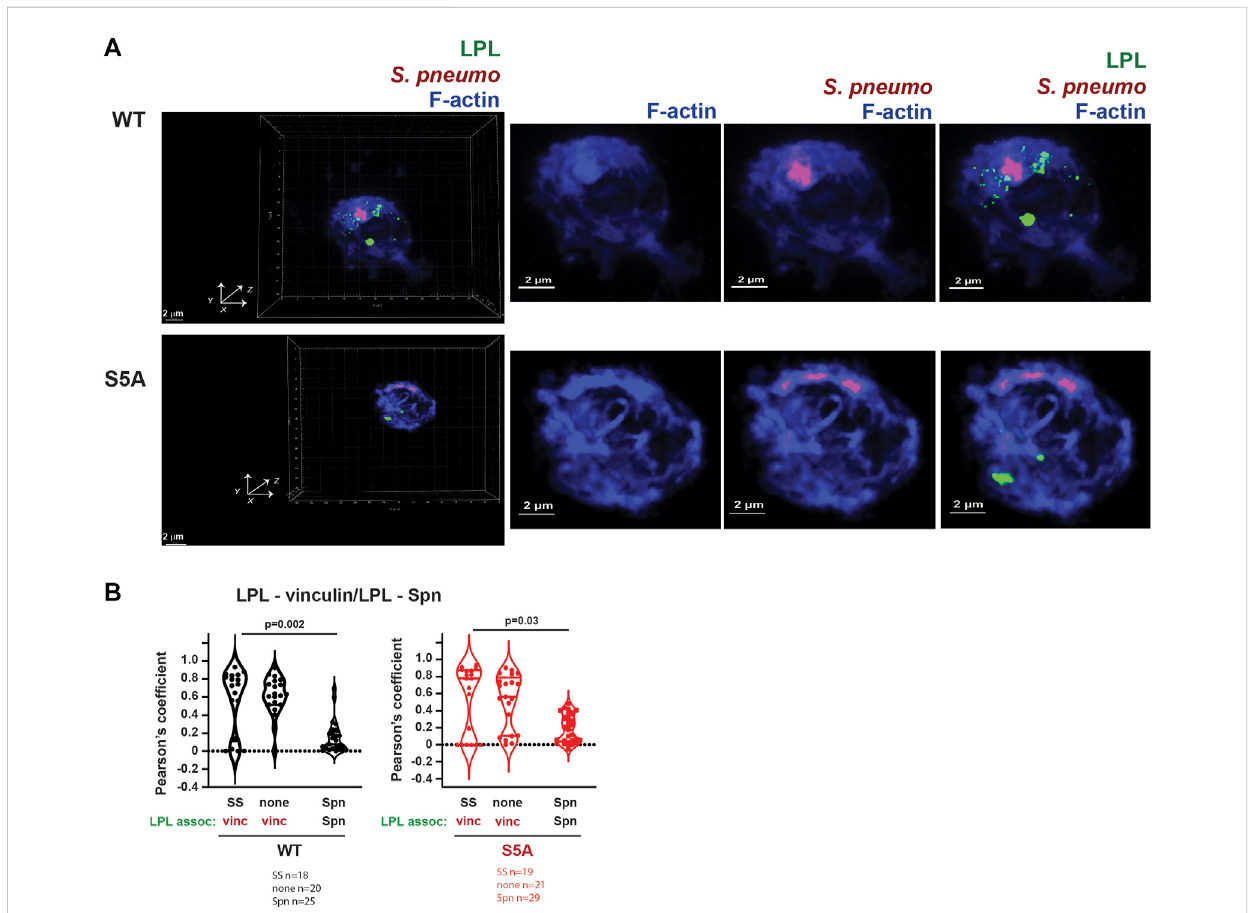
FIGURE 12 Neither WT-LPL nor S5A-LPL signi fi cantly co-localized with phagosomes in AMs. (A) Visualization of LPL (green), S. pneumoniae (red) and F-actin (blue) in AMs from matched WT and S5A mice after incubating with Spn-RFP for 60 m. Images in left panels show 3D reconstruction of Z-stack confocal micrographs.Other panelsare 2DXYprojectionsshowingF-actinonly, F-actin +Spn(purple),andLPL +F-actin +Spn.Grids show2 μ m increments and are optimal for size assessment; scale bars in subsequent panels are derived from grids. (B) Pearson ’ scoef fi cient was calculated for LPL and vinculin (Figures 4, 5, 8) or for LPL and Spn (Figure 12A). Each symbol represents the coef fi cient for one cell. “ SS ” = serum stimulation, “ none ” = incubation for 60 min without additional stimulation; “ Spn ” = incubation with Spn-RFP. p -values determined by